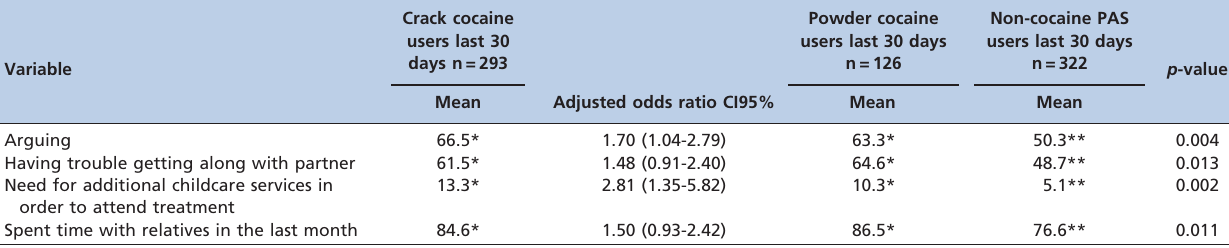
Table 1 - Family problems among 741 crack, cocaine and other drug users.